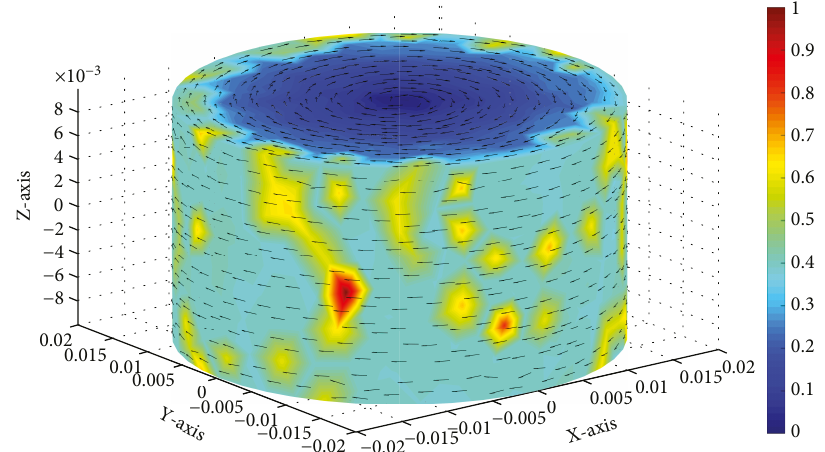
Figure 15: The distribution of the modal current corresponding to the only radiative resonant CM at